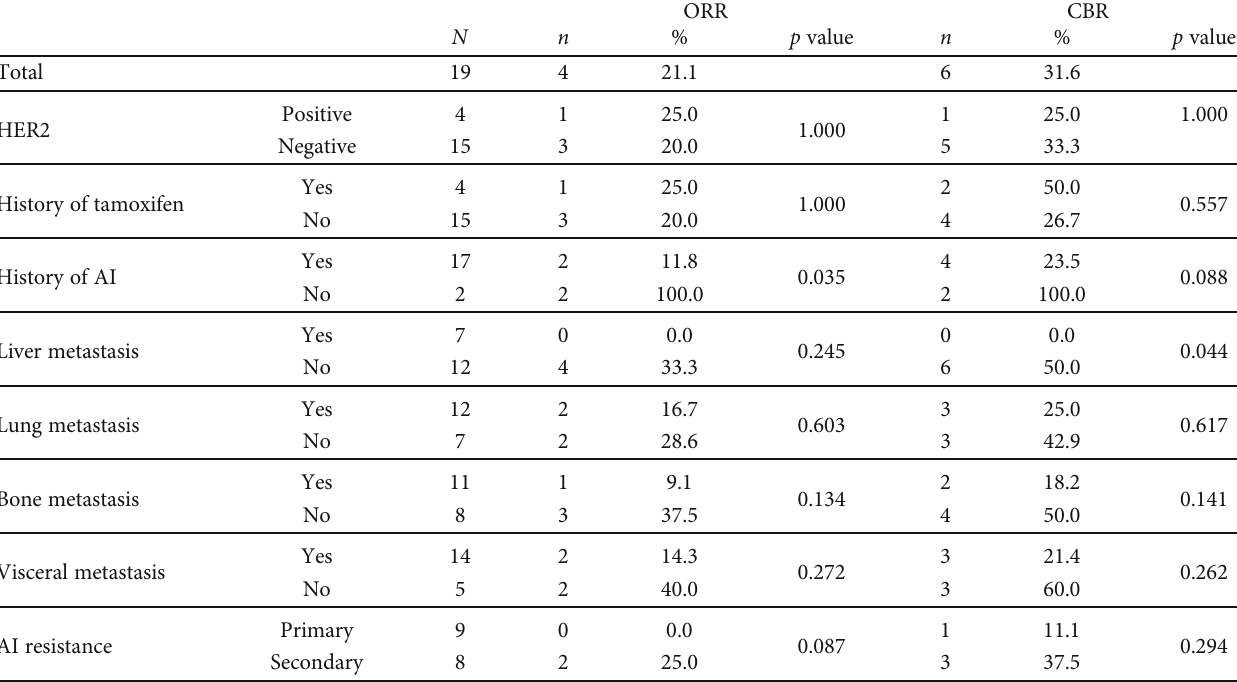
Table 2: Factors predictive of high-dose toremifene therapeutic e ffi cacy.